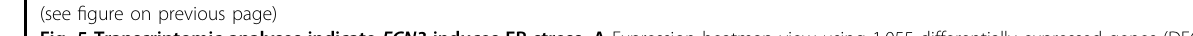
Fig. 5 Transcriptomic analyses indicate FCN3 induces ER stress. A Expression heatmap view using 1,055 differentially expressed genes (DEGs) from duplicate samples of control empty virus (EV) and FCN3 -virus-transduced cells. Genes with indicated gene symbols were used in validation experiment. B Gene set analysis on 595 up-regulated genes (top) and 460 down-regulated genes (bottom) for KEGG pathways and Gene Ontology (GO) biological processes. Top 5 scoring terms are shown in the plots. The full list is provided in Supplementary Table 3. Black dashed vertical lines represent the FDR threshold of 0.05. C Quantitative real time RT-PCR was performed to con fi rm RNA-Seq results. Five up-regulated and fi ve down- regulated genes were examined after transduction with control or FCN3 -expressing virus. D Immunoblots of ER stress markers HSPA5 and DDIT3 in A549 cells with or without 4-phenylbutyric acid (4-PBA) treatment. A549 cells were mock treated, EV transduced or FCN3 -virus-transduced and cultured for 48 h prior to sampling. HSPA5 and DDIT3 were induced in FCN3 -virus-transduced cells, and 4-PBA treatment effectively down-regulated these ER stress markers. ɑ – Tubulin was used as the loading control. E Apoptosis of A549 cells were examined by fl ow cytometry 96 h after viral transduction with or without 4-PBA. The percentage of apoptotic cells decreased with the alleviation of ER stress by 4-PBA treatment. Graph to the bottom summarizes the results. Data are mean ± SEM of three independent experiments, and (**) represents P -value of <0.01 from t test. F Subcellular localization of FCN3 in A549 cells. Nuclear GFP expression indicates the FCN3 -virus-transduced cell. V5 staining shows localization of ectopic FCN3 in